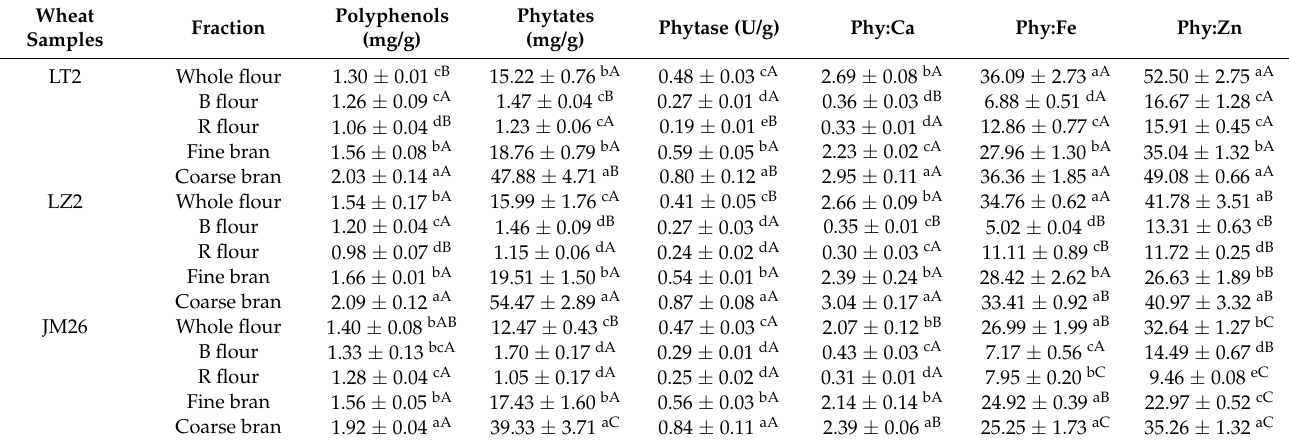
Table 5. Polyphenols and phytates contents, phytase activity, and mineral molar ratios of milling fractions of LT2, LZ2, and